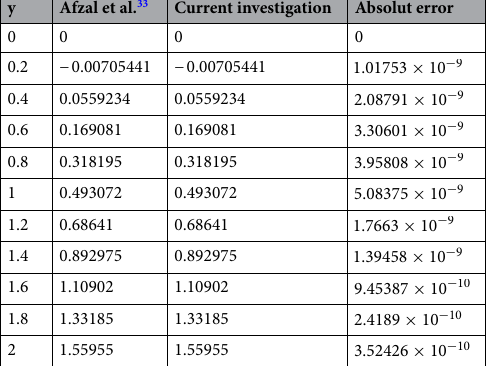
Table 2. Comparison of concentration profile solution with x = 1, m 1 = 0.5, α = 0.5, N TC = 0.8, N b = 0.1, N t = 0.8, N CT = 0.8